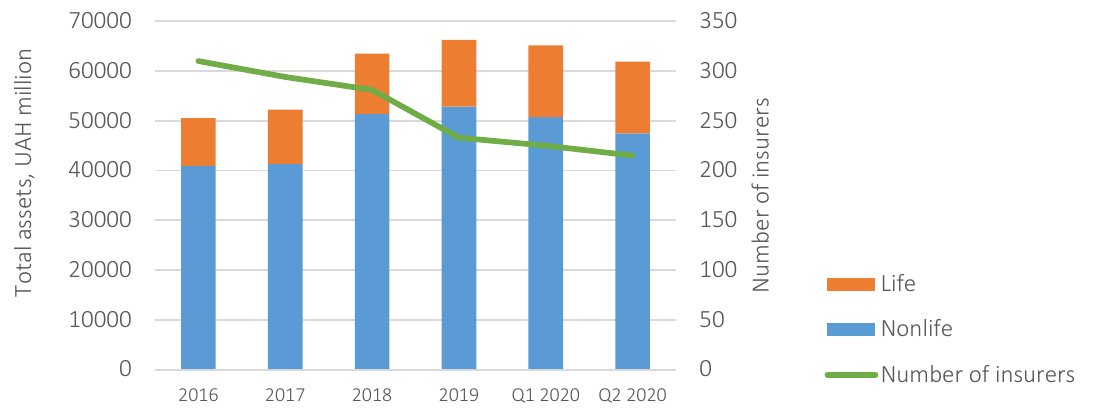
Figure 2. Number of insurers and volume of their total assets (billion